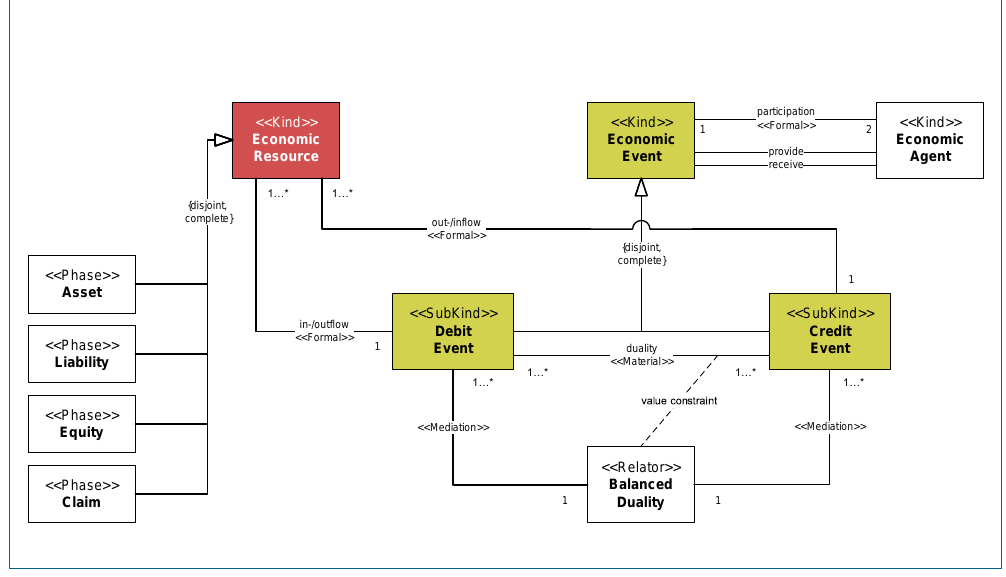
Figure 12. OntoREA Accounting Model – REA-based ALE Accounting in